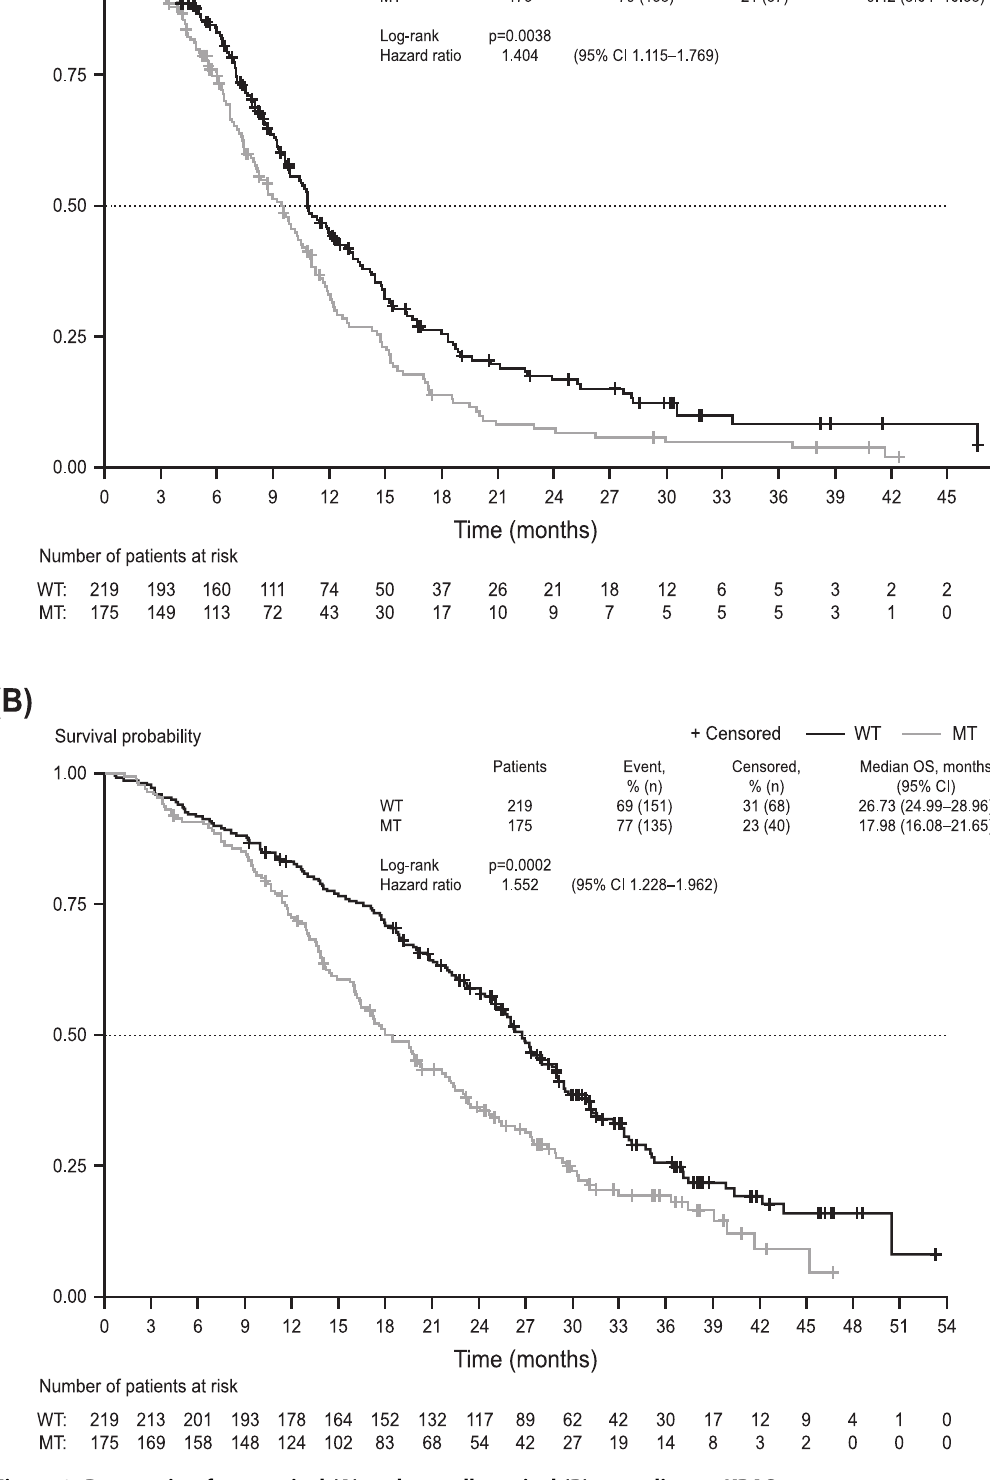
Figure 2. Progression-free survival (A) and overall survival (B) according to KRAS status.